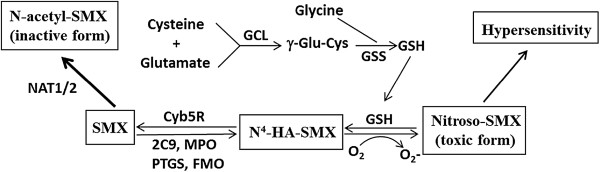
Pathways of SMX metabolism, bio-activation and detoxification, and pathway of GSH biosynthesis. NAT1/2, N-acetyltransferase 1 and 2; 2C9, cytochrome p450 2C9; MPO, myeloperoxidase; PTGS, prostaglandin-endoperoxide synthase; FMO, flavin containing monooxygenase; Cyb5R, NADH-cytochrome b5/cytochrome b5 reductase complex; GSH, glutathione; GCL, glutamate-cystein ligase, including catalytic and regulatory subunits GCLC and GCLM; GSS, glutathione synthetase.